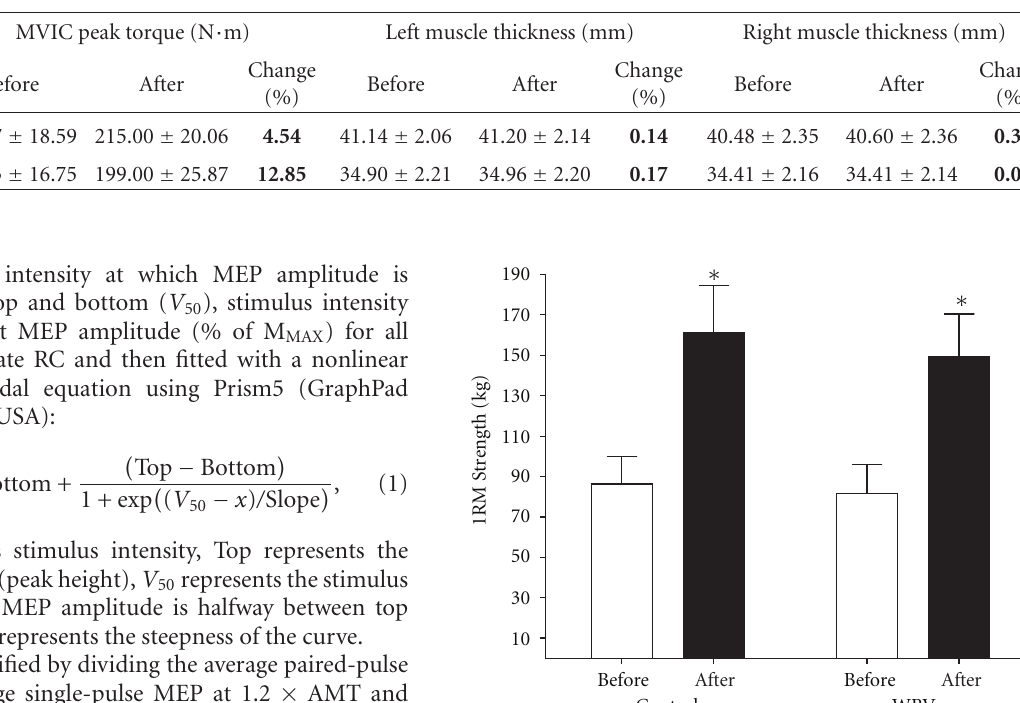
Table 1: Mean ± SE values and percentage change for maximum voluntary isometric contraction torque (N · m) and muscle thickness of the left and right anterior thigh.